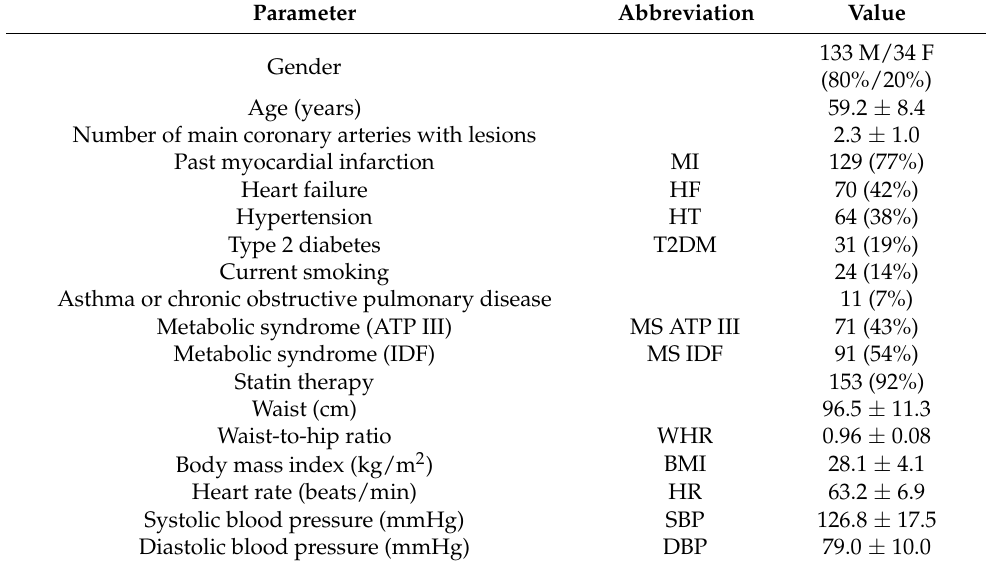
Table 1. Characteristics of the study group ( n =